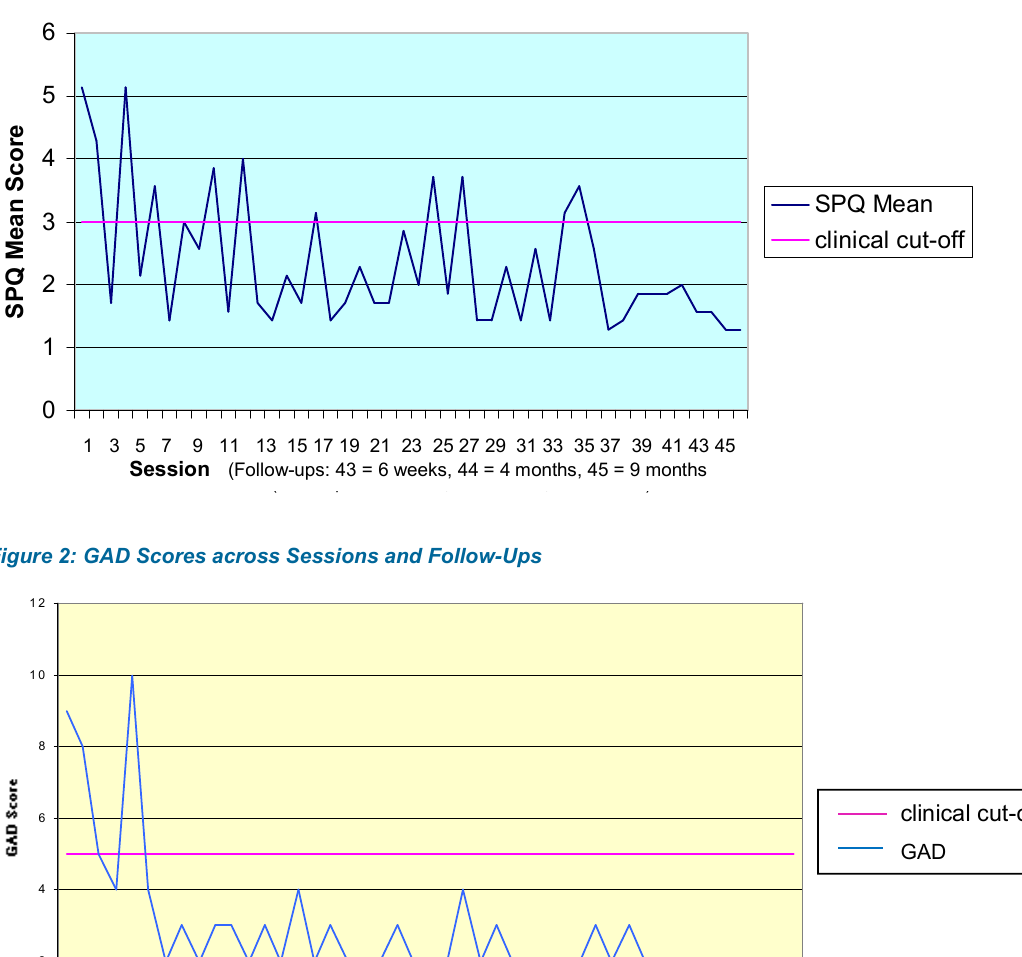
Figure 1: SPQ Mean Score across Sessions and Follow-ups